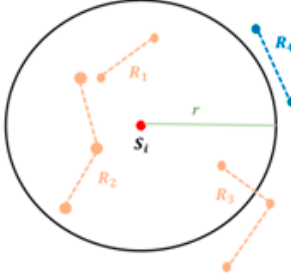
Figure 2. An illustration of the reachable region of station Si and the corresponding bike routes.